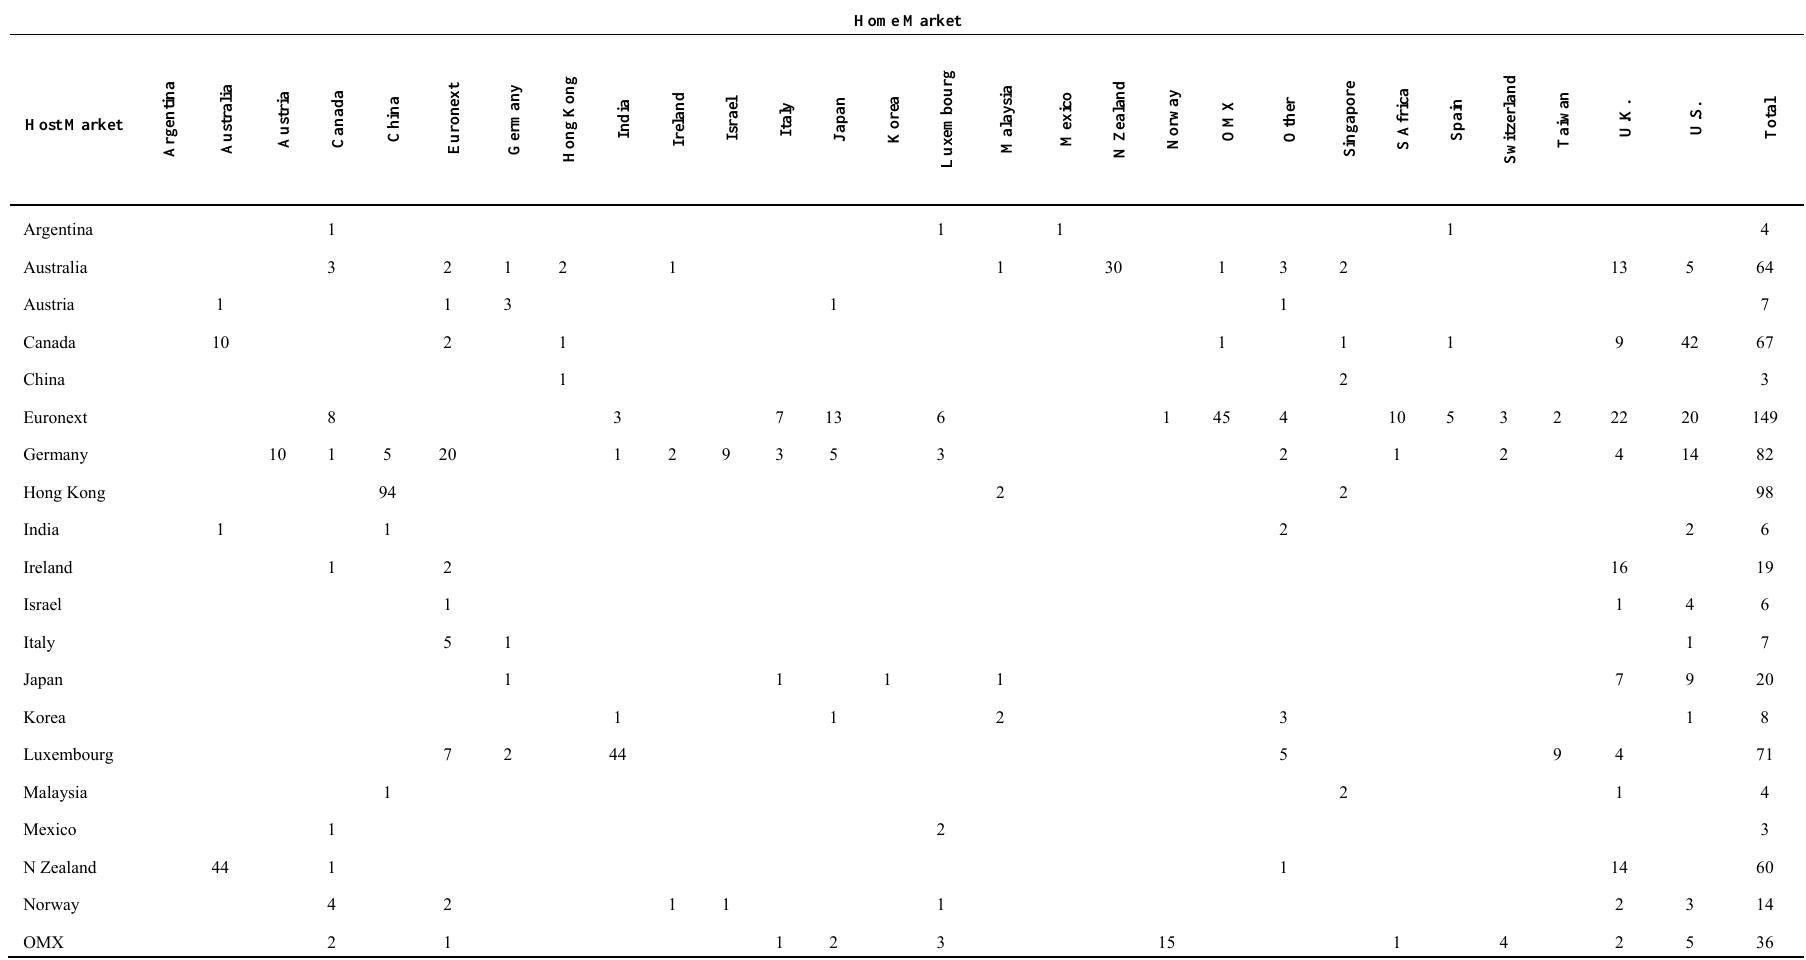
Table 1. Cross Tabulation of Home and Destination Country